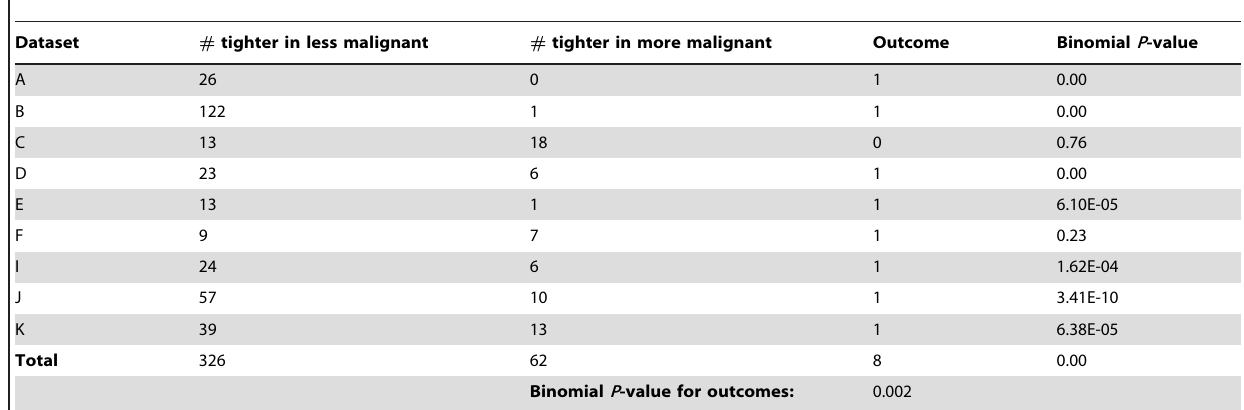
Table 4. Statistical significance of network deregulation in malignant phenotypes.